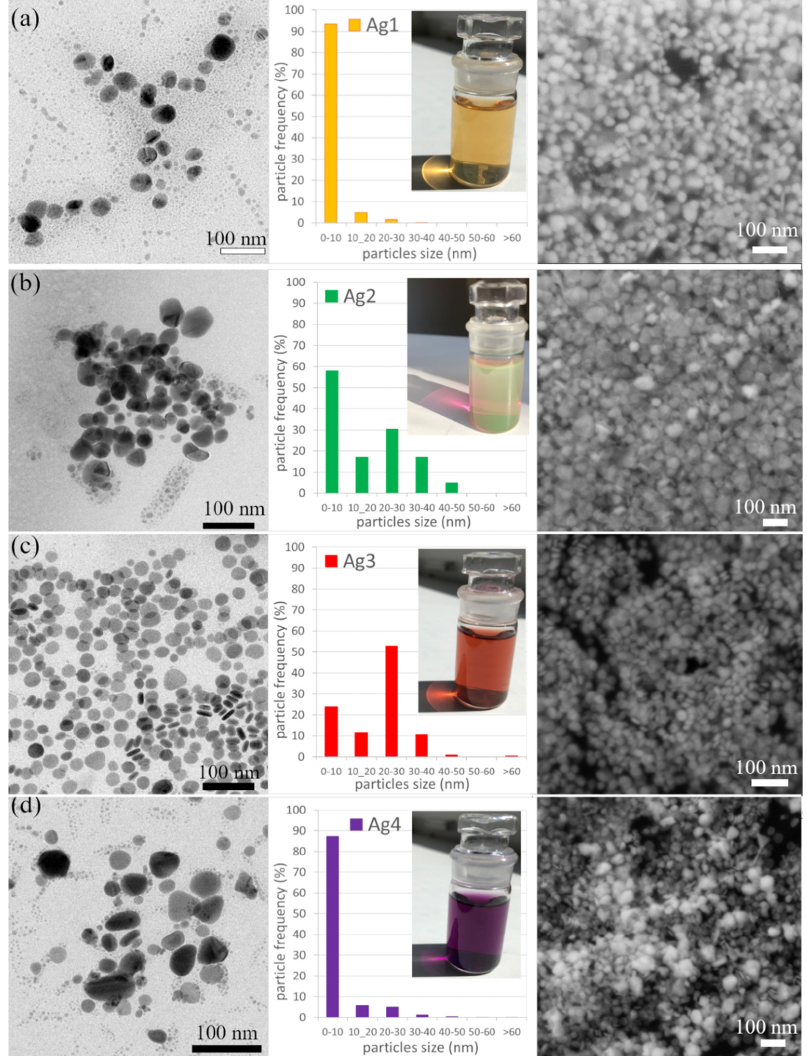
Figure 6. TEM images, size distribution histograms and SEM images of samples Ag 1 ( a ); Ag 2 ( b ); Ag 3 ( c ); and Ag 4 ( d ) on the 14th day of the experiment.